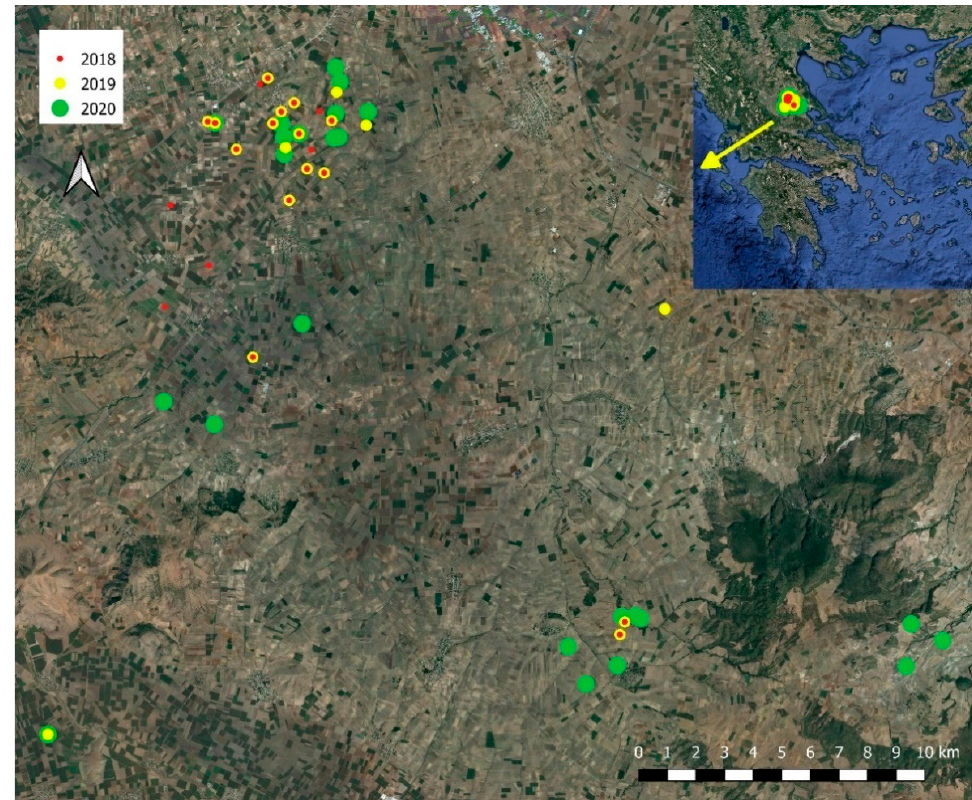
Figure 1. Satellite image of the Thessaly plain, Greece (inset), with the studied fields indicated with different colors for the three growing periods.